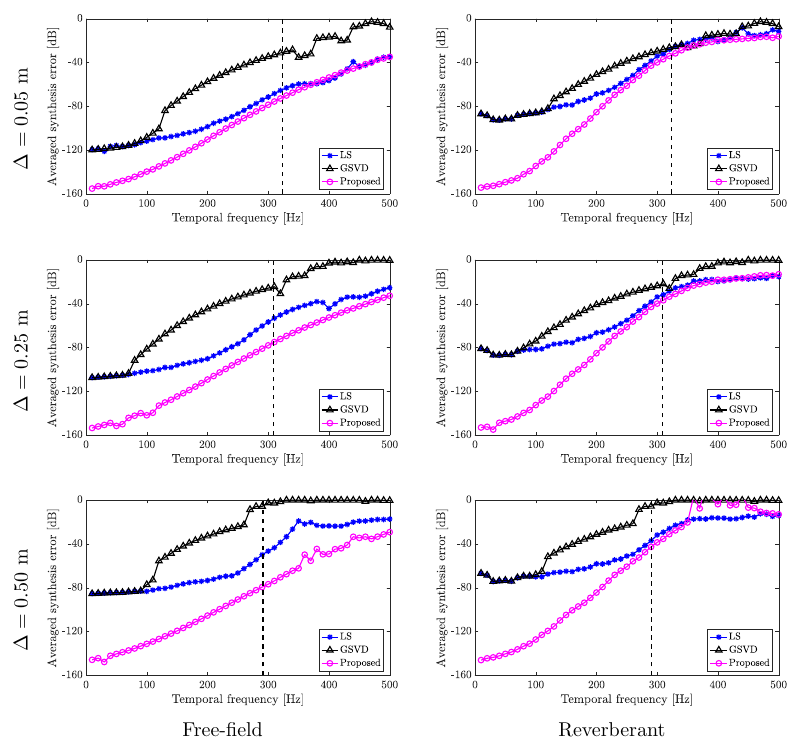
Figure 8. Results of spatially-averaged synthesis error for interior sound field within r ≤ 1.5 m.